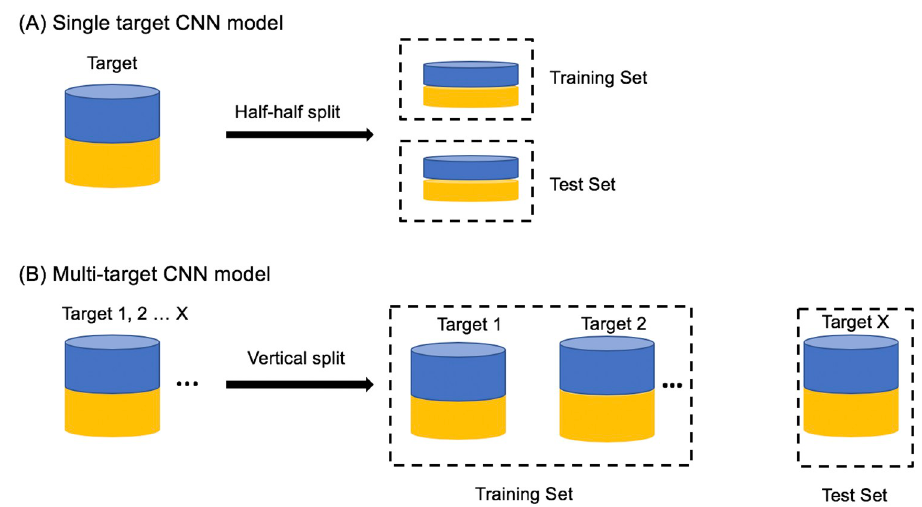
Fig 1. Data preparation for model training and testing. The training set and test set for (A) the singe target CNN model and (B) multi-target CNN model. Blue denotes actives and yellow denotes decoys.